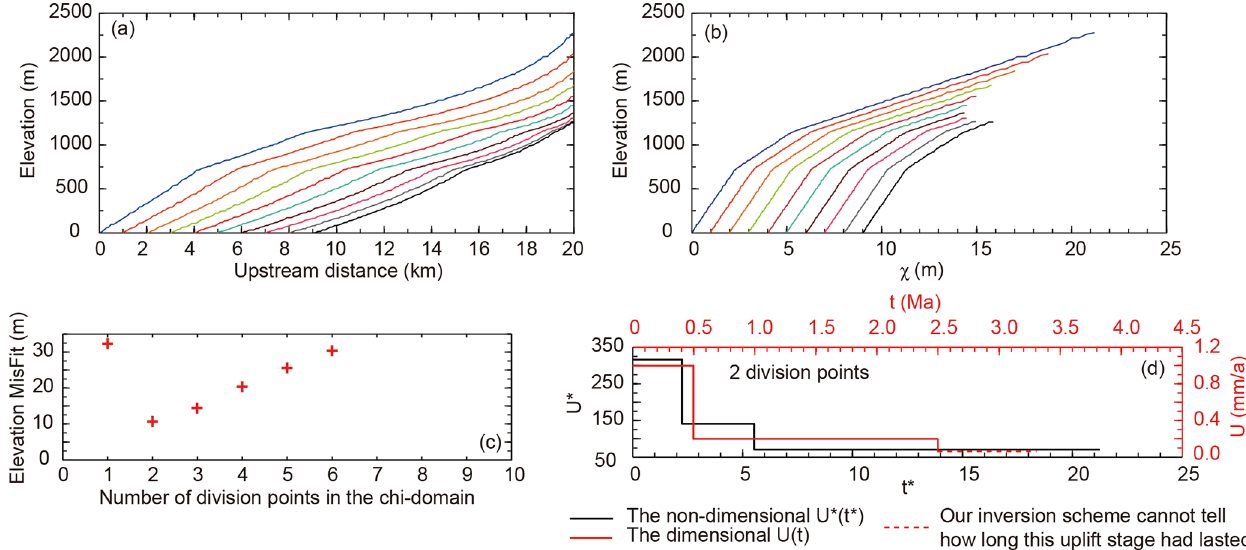
Figure 5. Inversion of numerical rivers with n = 2. (a–b) River profiles and χ − z plots of numerically generated rivers with length that ranges between 12–21km, k a ∼ 2 to 1.55 and h ∼ 0 . 67 to 4.27. The stream-power parameters are n = 2, K = 1 × 10 − 8 m − 0 . 8 a − 1 and m = 0 . 9. The time (d t ) and space (d x ) steps are 100 years and 100m, respectively. The applied uplift rate history is U 0 = 0 . 05mma − 1 prior to 2.5Ma, U 1 = 0 . 2mma − 1 between 0.5–2.5Ma and U 2 = 1 . 0mma − 1 between 0.0–0.5Ma. Profiles are shown with added elevation noise. See text for details. (c) Elevation misfit, Eq. (28), as a function of the number of division points. (d) The inferred scaled (black line) and dimensional (red line) uplift history, based on two division points. Introducing correct dimensions was achieved by using the known model n and K